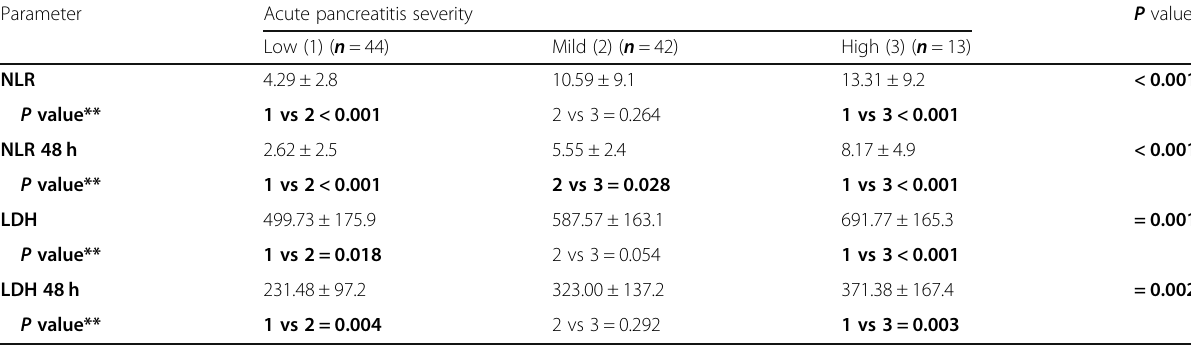
Table 6 NLR and LDH comparison regarding disease severity